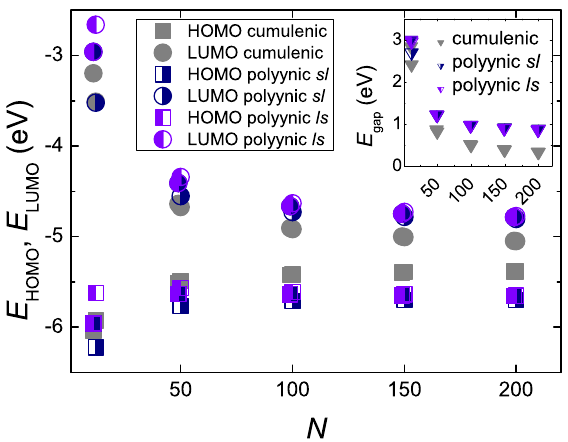
Figure 9. The eigenenergies of the Highest Occupied Molecular Orbital (HOMO), the Lowest Unoccupied Molecular Orbital (LUMO) and the energy gap (inset) between them, as functions of the number of carbon atoms in the chain, N , as obtained by our DFT simulations, at the B3LYP/cc-pVTZ level of theory. The points shown correspond to N = 11, 12, 49, 50, 99, 100, 149, 150, 199, 200.